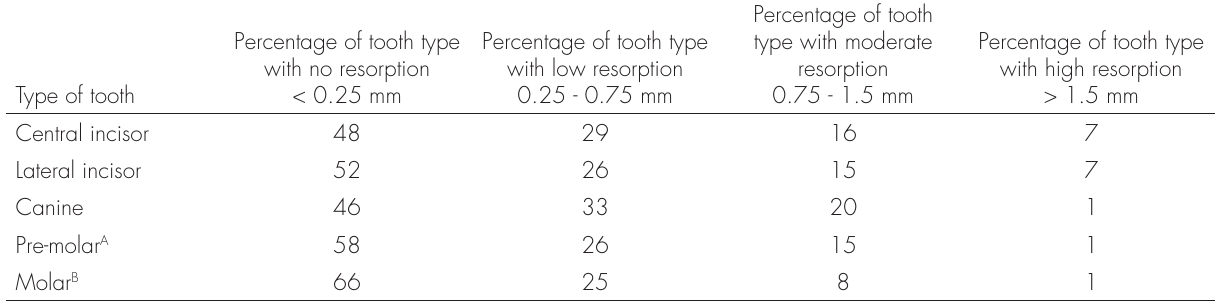
Table IV. Percentages of teeth categorised by level of resorption. The modal class of root was used for multi-root teeth.